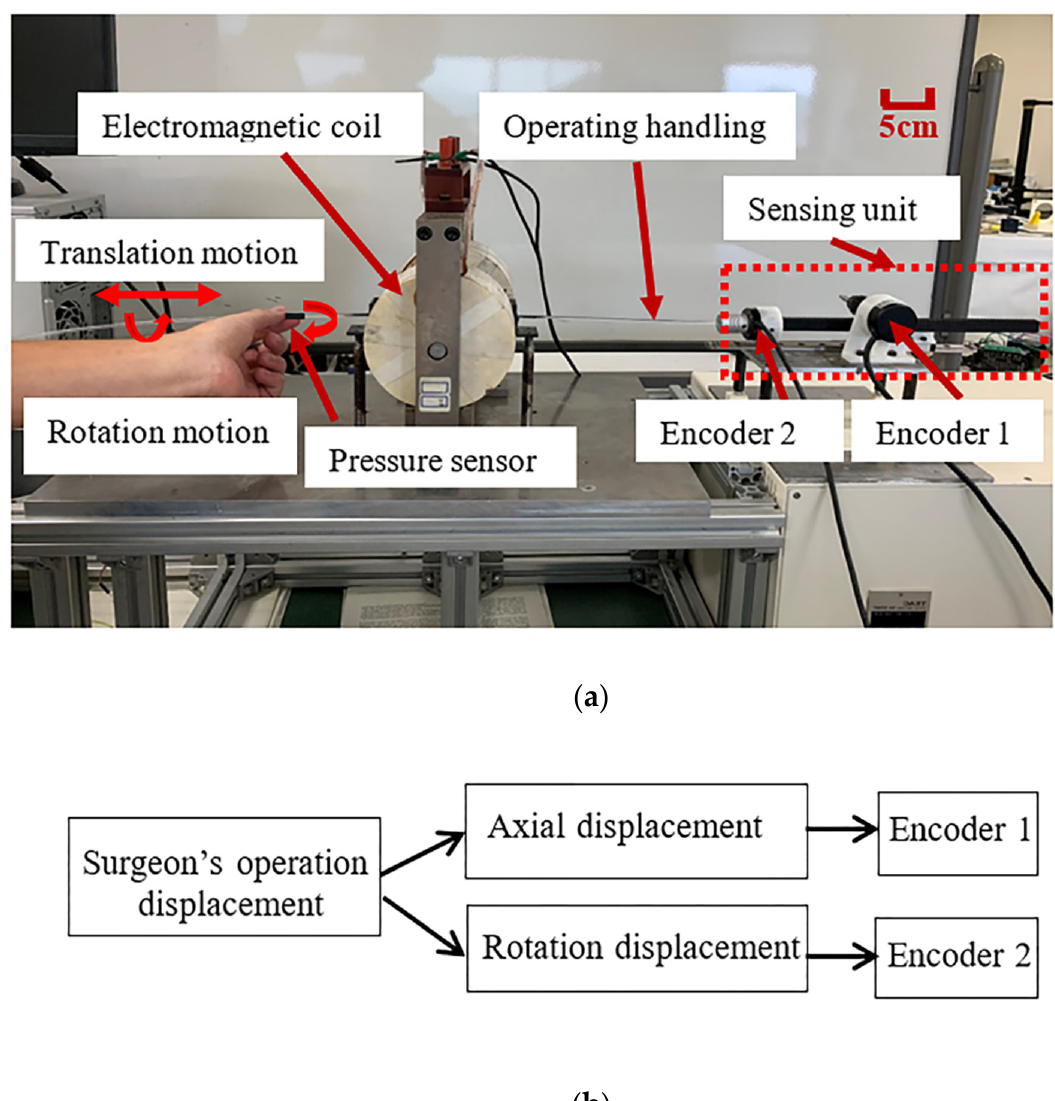
Figure 2. ( a ) Master manipulator operation interface diagram. ( b ) Operation information recording.